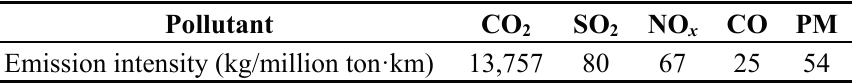
Table 2. Pollutant emission intensity in coal